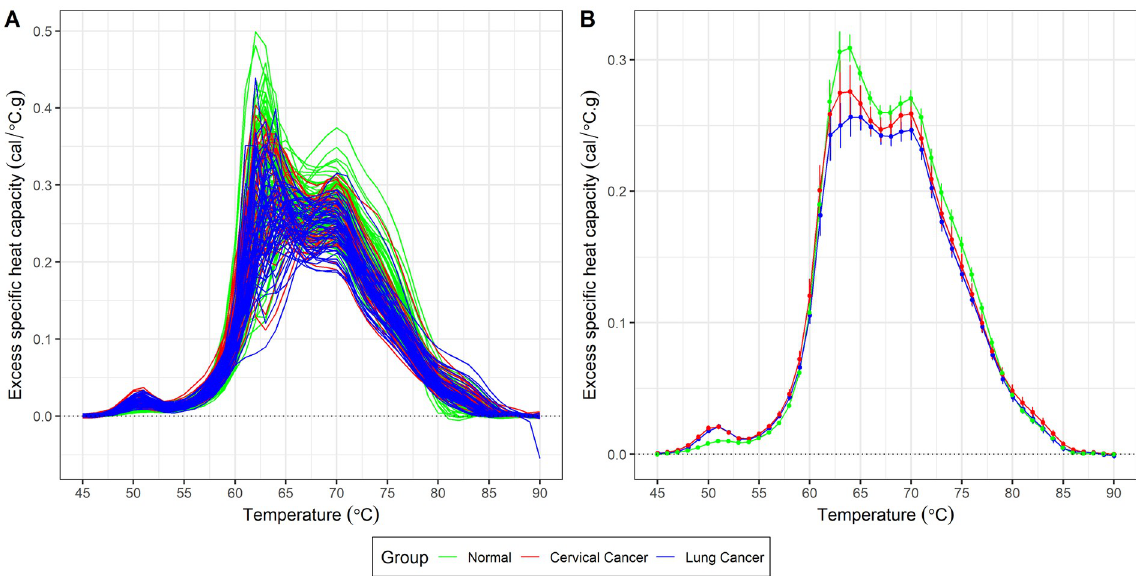
Fig 1. The composite line plot and error bar plot. (A) Composite line plot of HC values at each temperature data point for 97 normal (green), 35 cervical cancer (red) and 54 lung cancer (blue) samples. (B) Composite error bar plot of HC values at each temperature data point for three groups: normal (green), cervical cancer (red) and lung cancer (blue). The circles represent mean values and the error bars represent the 95% confidence interval.